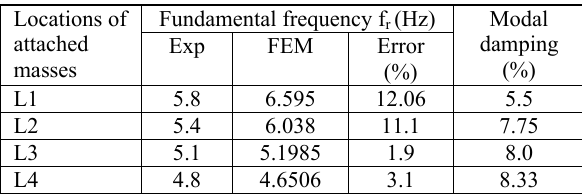
Table 8. Fundamental natural frequencies and modal damping ratio with attached mass of the CFFF